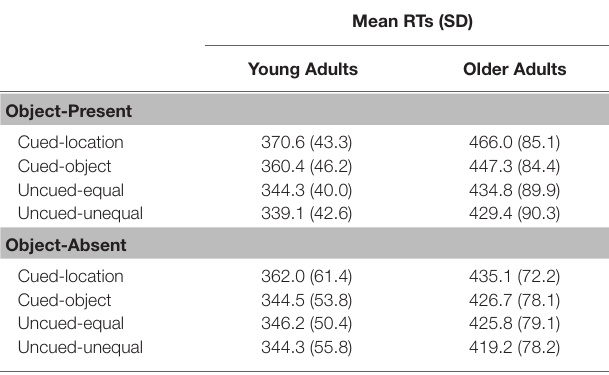
TABLE 3 | Mean reaction times and standard deviations for Experiment